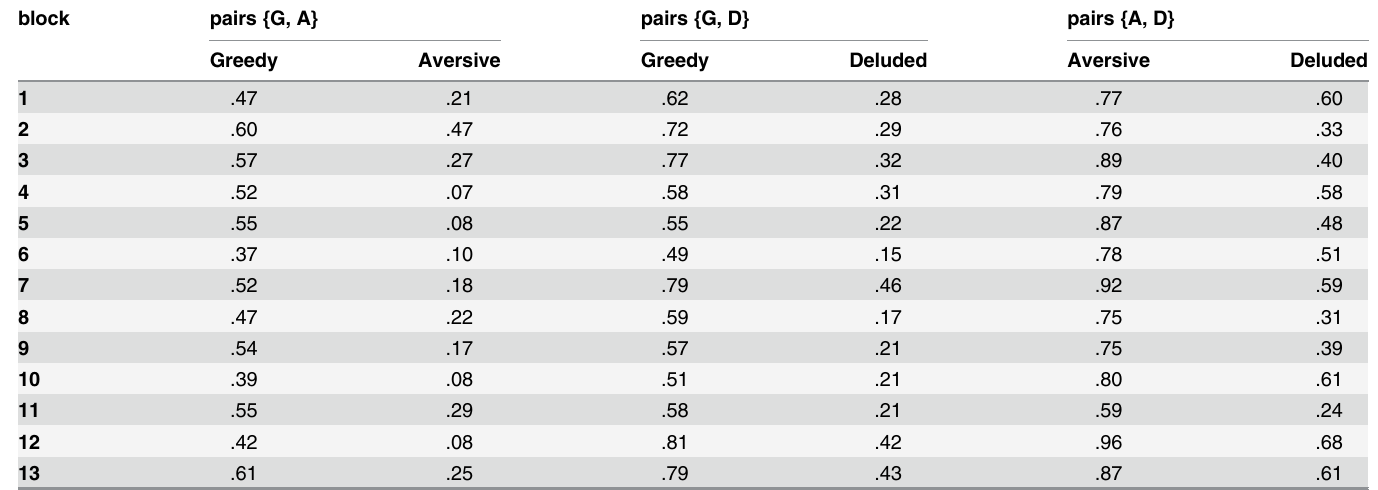
Table 6. Conditional probabilities of preferring first item in a pair for the BTQ-SF. block pairs {G, A} pairs {G, D}